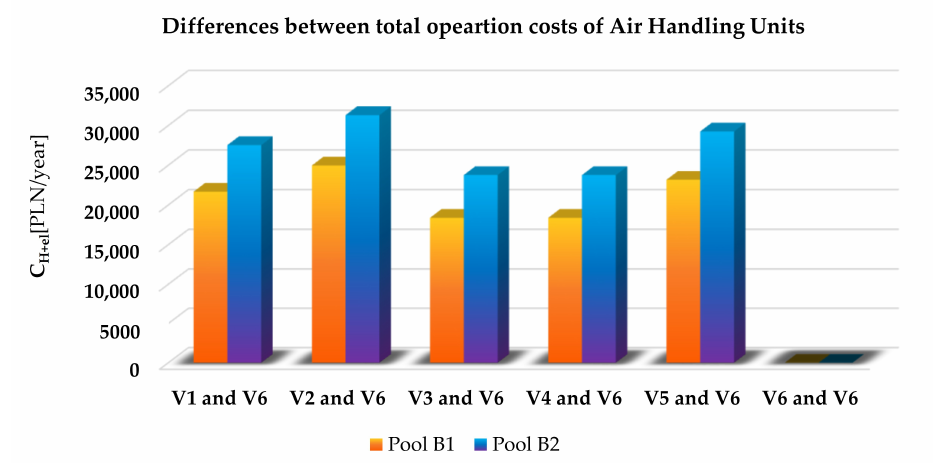
Figure 7. The di ff erences between the operating costs of the individual variants—compared to the cheapest option (variant 6)—for sports pool B1 and recreation pool